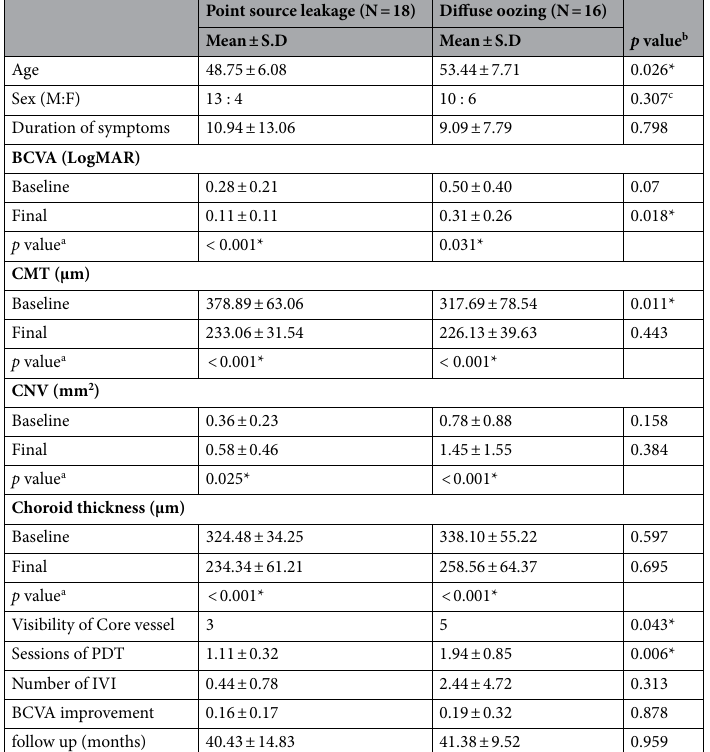
Table 3. Differences in age, sex, duration of symptoms, BCVA, CMT, CNV and CT in patients with point source leakage and diffuse oozing. a Wilcoxon Signed-Rank Test. *: p value < 0.05; b Mann–Whitney U test. *: p value < 0.05; c Fisher’s extract test. *: p value < 0.05. BCVA best corrected visual acuity, CMT central macular thickness, CNV choroidal neovascularization, logMAR logarithm of the minimal angle of resolution, PDT verteporfin photodynamic therapy, SRF subretinal fluid. † Baseline CNV was measured when subretinal fluid was totally or subtotally reabsorbed 1 month after photodynamic